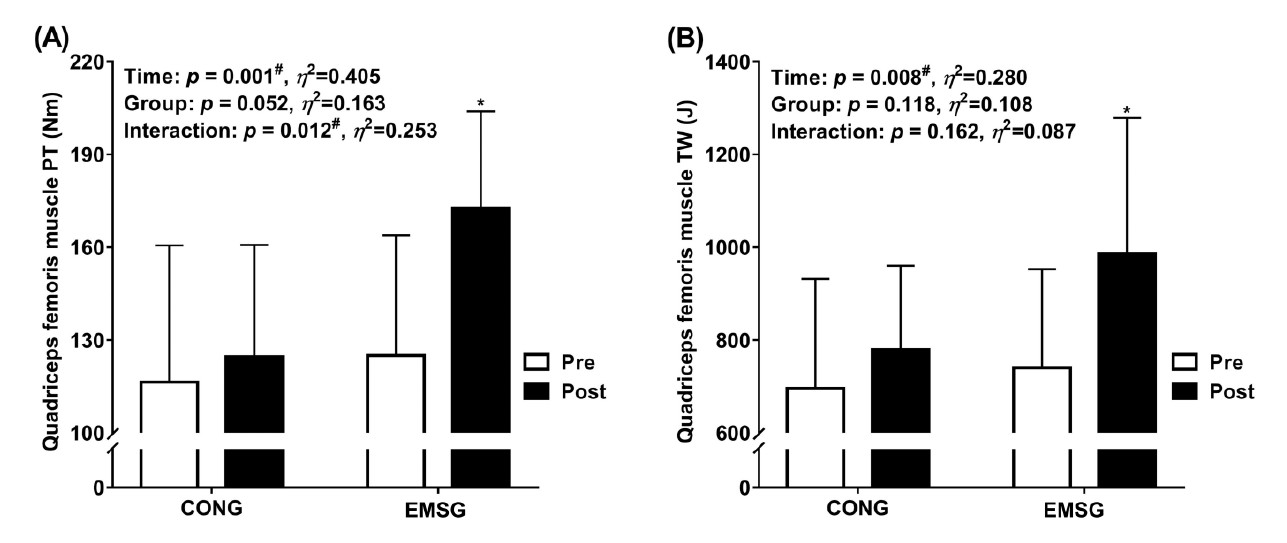
Figure 7. The rehabilitative exercise programs’ effects on isokinetic muscle function. ( A ) Compared in quadriceps femoris muscle PT. ( B ) Compared in quadriceps femoris muscle TW. control group; CONG, electro muscle stimulation group; EMSG, peak torque; PT, total work; TW. # p < 0.05: main effect or interaction; * p < 0.05: pre- and post-test.